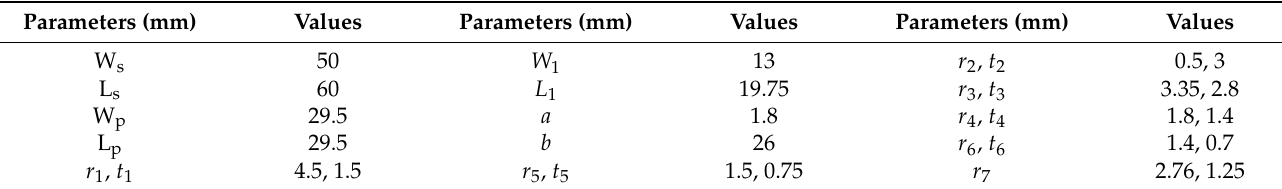
Figure 2. ( a ) Simulated human female voxel model and simulation setup, ( b ) the fabricated prototype of the antenna, ( c ) measurement setup on chest, and ( d ) the measurement setup on breast phantom. Table 1. Antenna parameters dimensions.